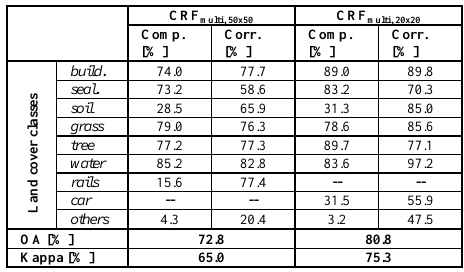
Table 1: Overall accuracy [%], kappa index [%], completeness (comp.) and correctness (corr.) values [%] for the land cover classes build. , seal. , soil , grass , tree , water and car obtained by classification using the two-layer CRF approach based on superpixels of size 50 x 50 (CRF multi, 50x50 ) and of size 20 x 20 (CRF multi, 20x20